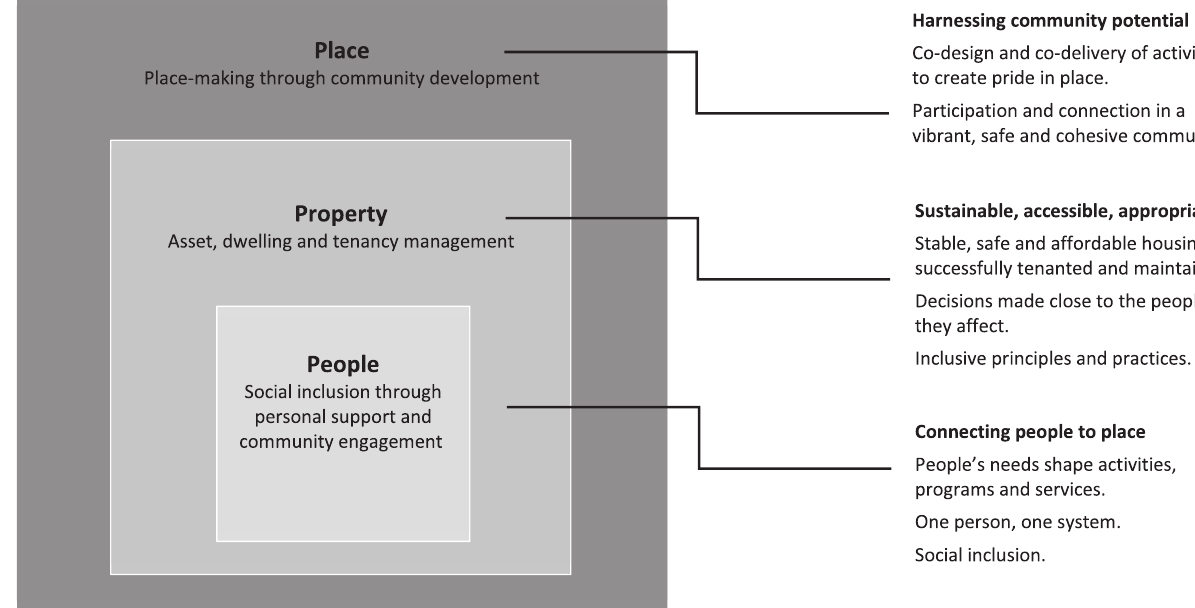
Figure 1. Better Places, Stronger Communities model (northern Adelaide): people, property and place. Adapted from AnglicareSA